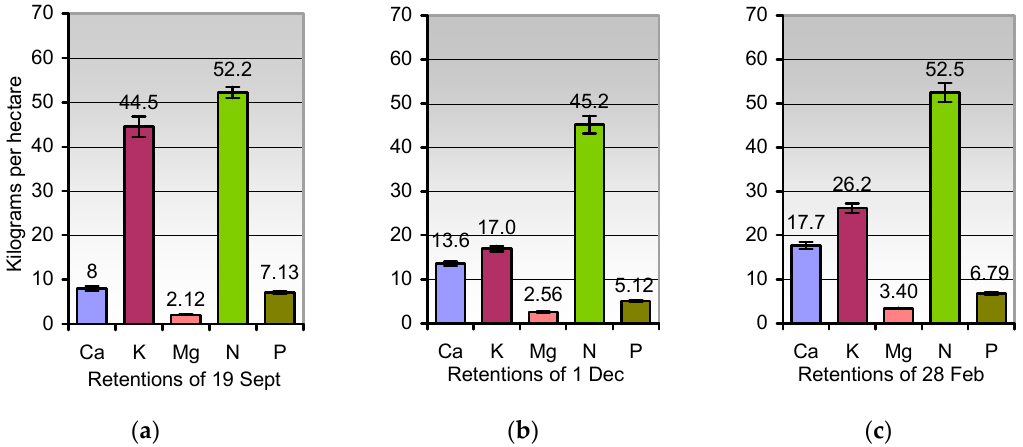
Figure 6. Rotation wheat-wheat: The cropland retention of the minerals (kg ha − 1 , figures heading the columns) in rooted stubbles 16 cm and in the regrowth of wheat from spilt grains prior to, and after ploughing-down on 28 September. See Table 4 for details. Error bars indicate ± SD. NPK stock in